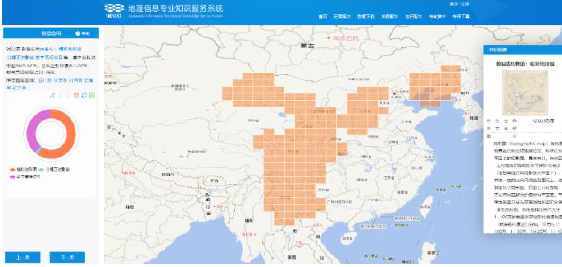
Figure 9 . Recommended applications for spatial data